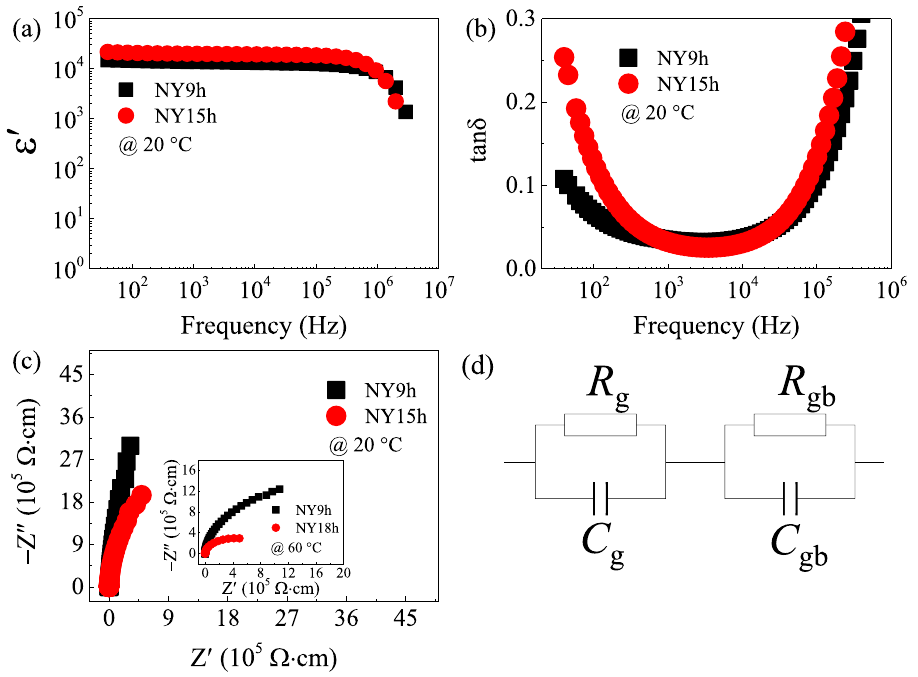
Figure 4. ( a ) Frequency dependencies of ε ′ at 20 °C of NY9h and NY15h ceramics. ( b ) Frequency dependence of tan δ. ( c ) Impedance complex (Z*) plots at 20 °C; its inset shows Z* at 60 °C. ( d ) Equivalent circuit represents the electrical heterogeneous microstructure of semiconducting grain and insulating grain